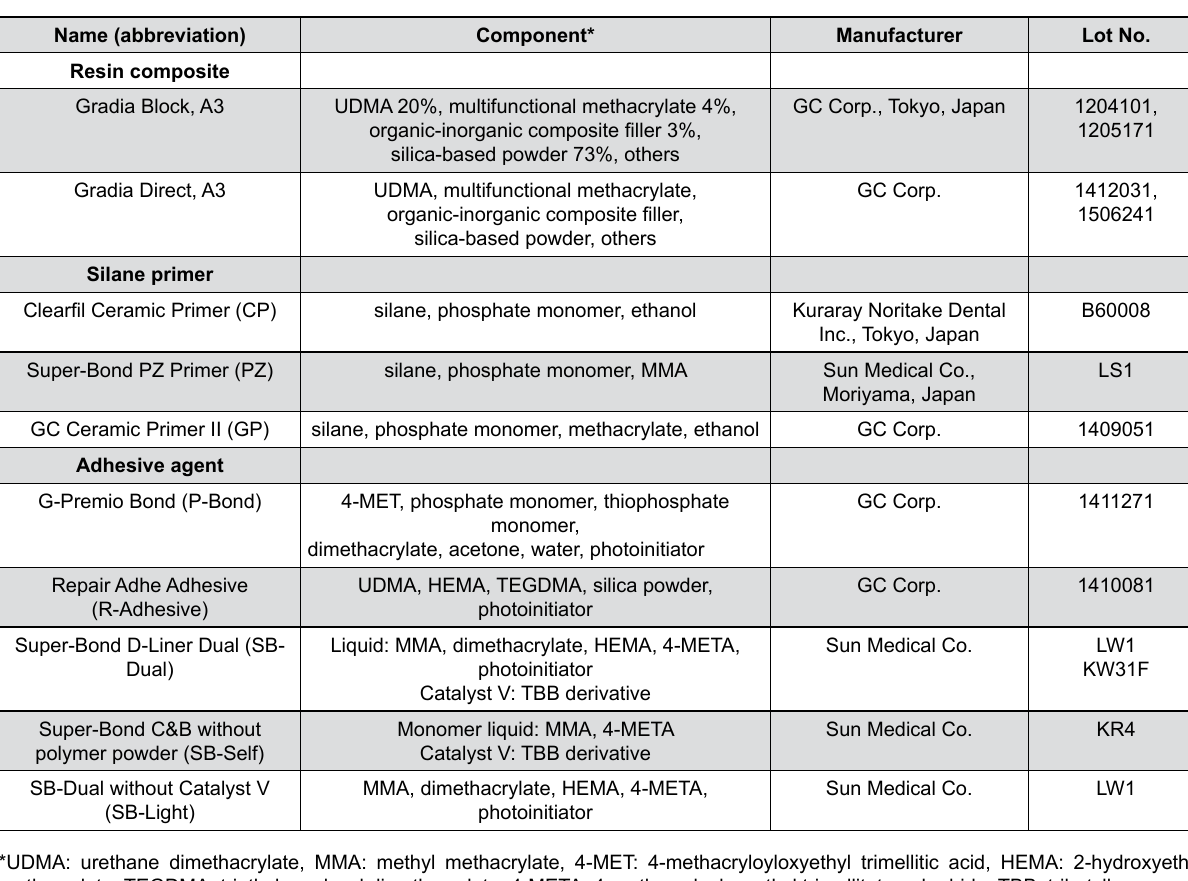
Figure 1- Resin composites, silane primers, and adhesives agents used for shear bond strength tests